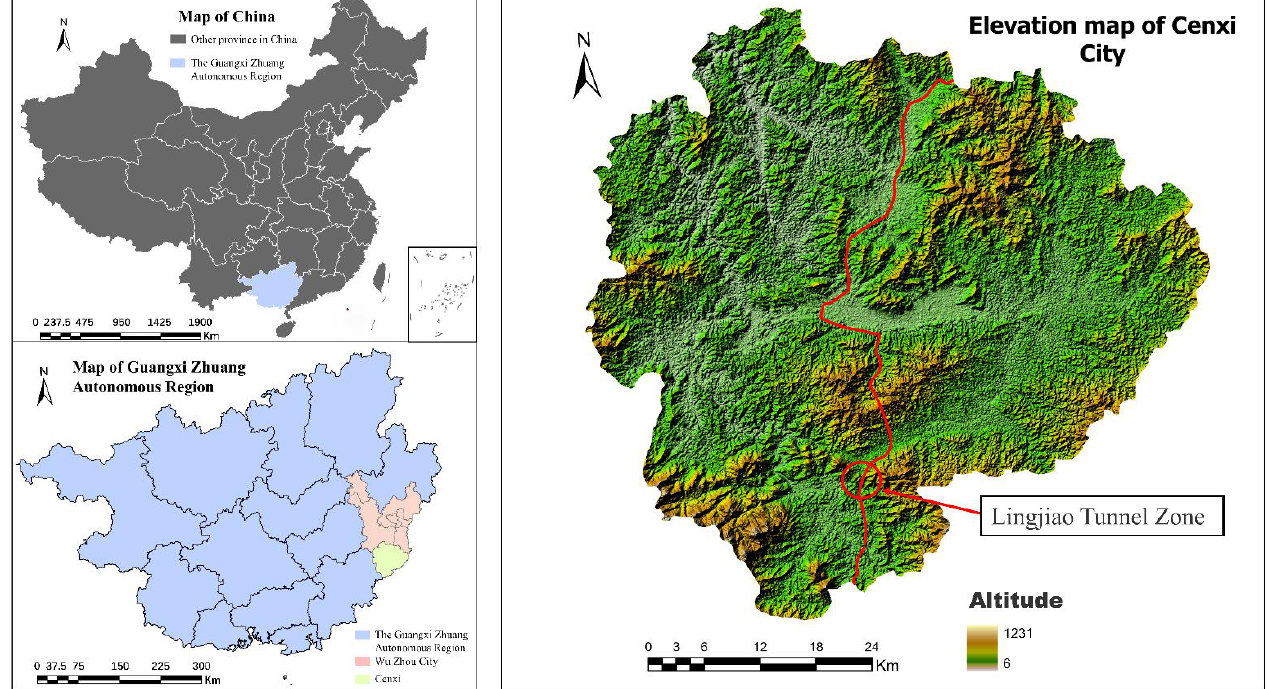
Figure 2. Address of Lingjiao Tunnel.